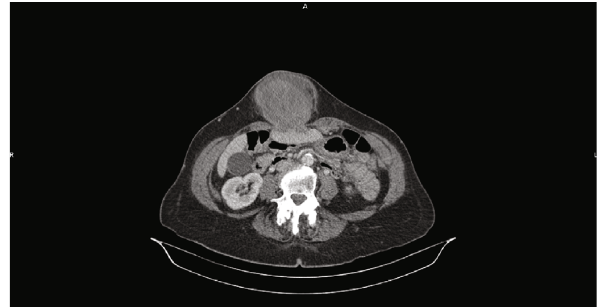
Figure 2: Axial section of injected CT abdominal scanner demonstrating herniation of liver segment III through the linea alba .